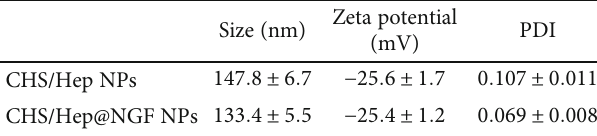
Table 1: Size and zeta potential of prepared